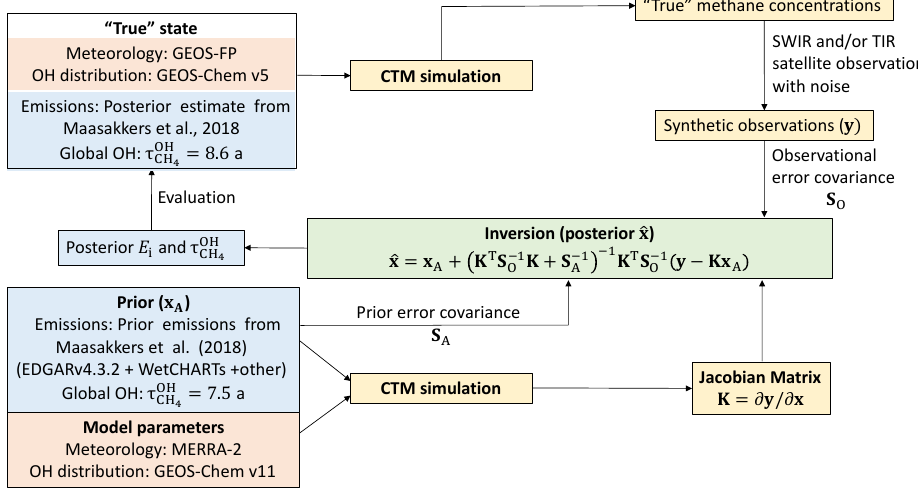
(cid:16) (cid:17) τ OH CH 4